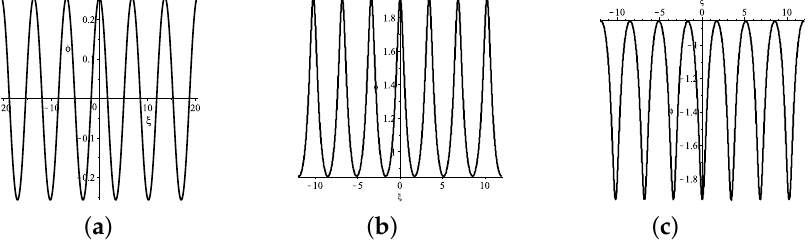
Figure 11. Periodic wave forms of system (5). ( a ) Defined by (23). ( b ) Defined by (24) + . ( c ) Defined by (24) − .